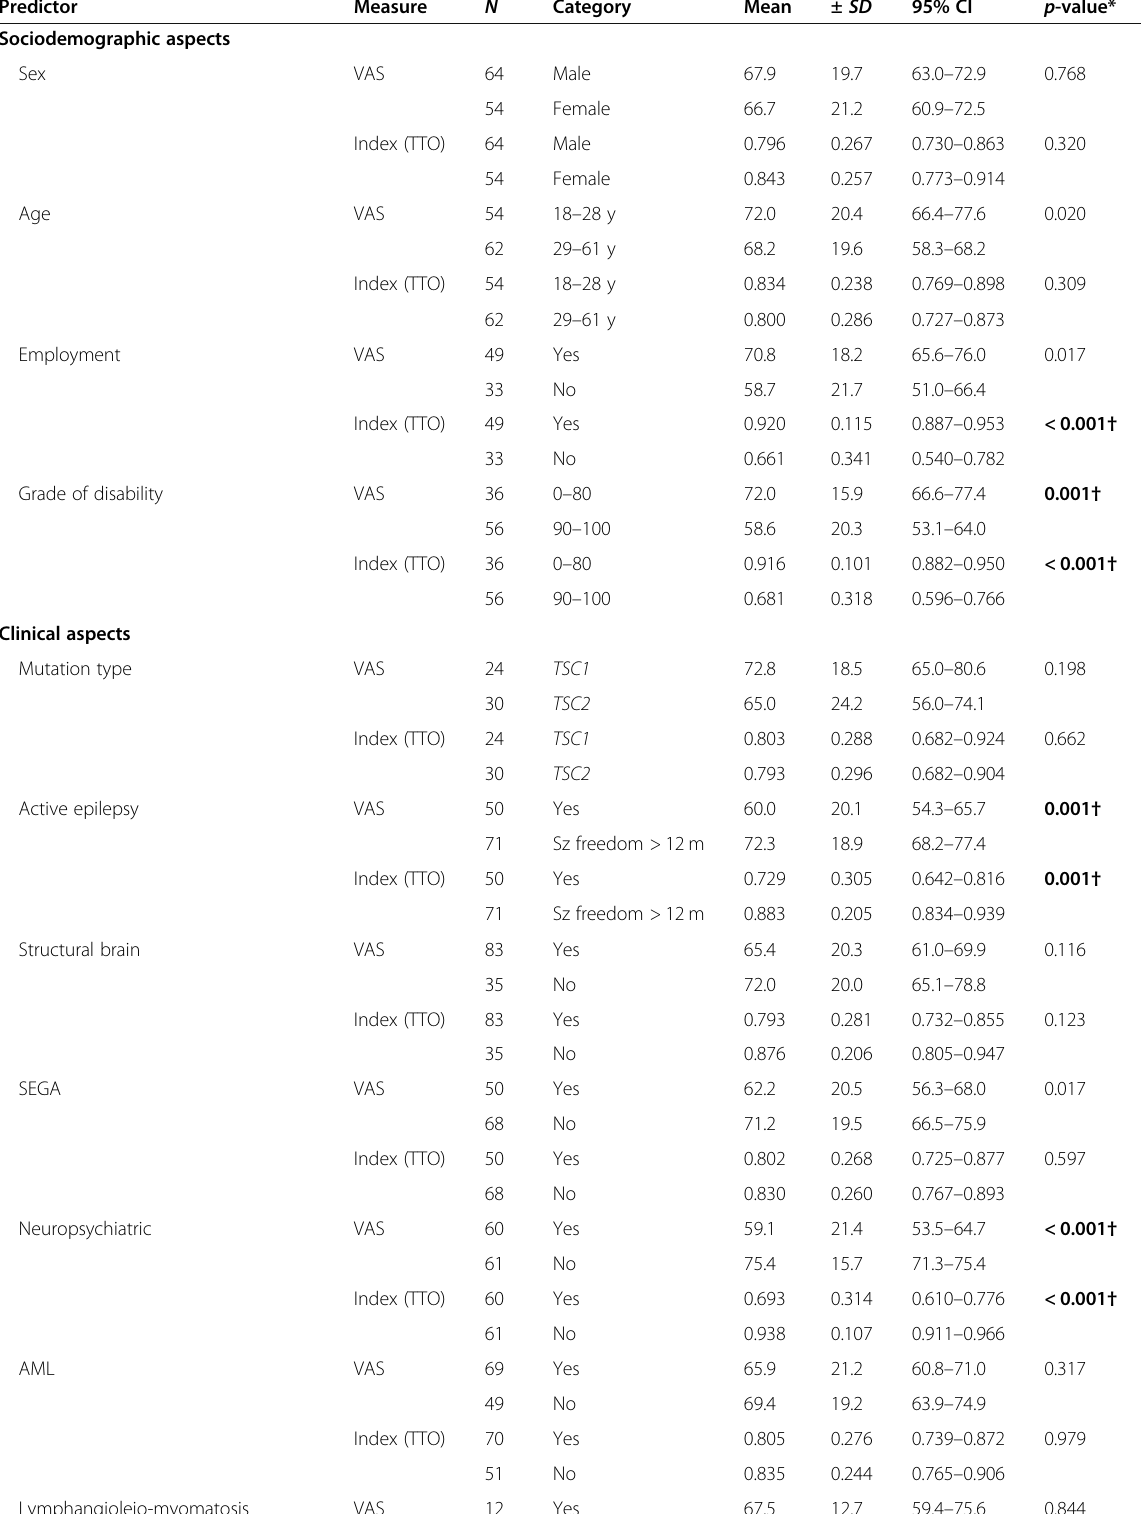
Table 2 Comparisons of generic quality of life among individuals with TSC, as measured by the EQ-5D (German version) questionnaire, according to several potential predictors and assessed by the Kruskal – Wallis and Chi-square tests Predictor